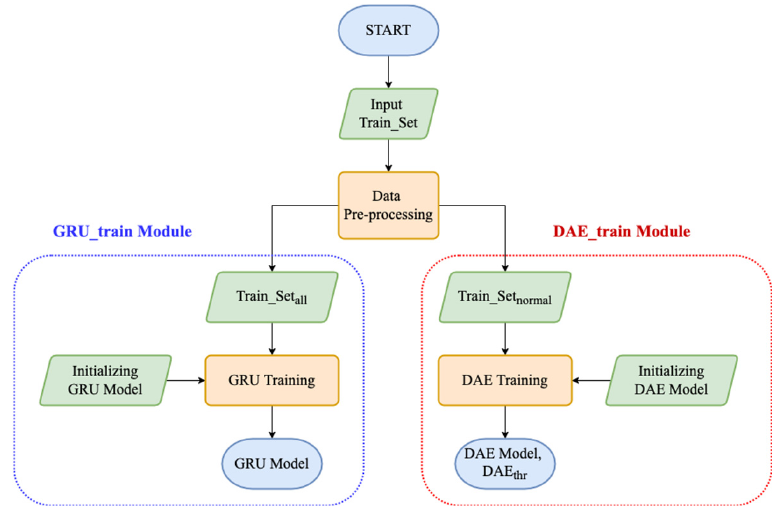
Figure 3. Operational process of the training mode.